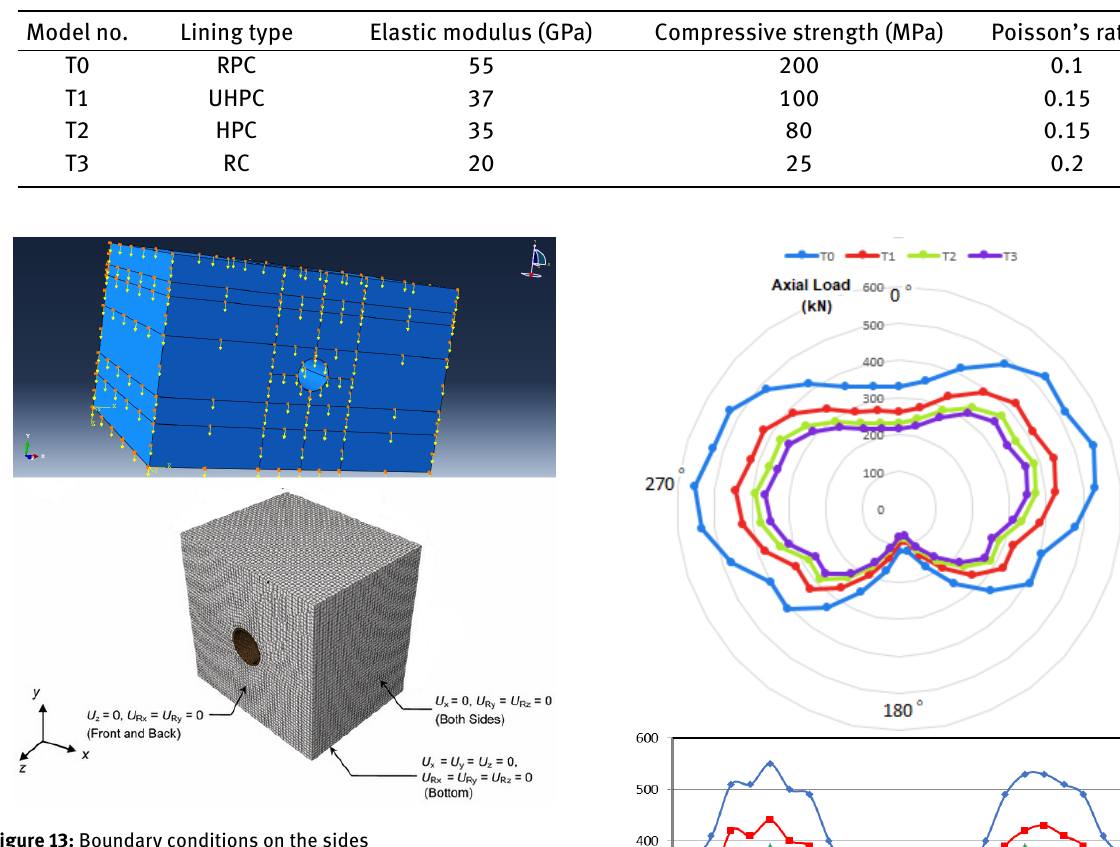
Table 5: Concrete specifications in the models